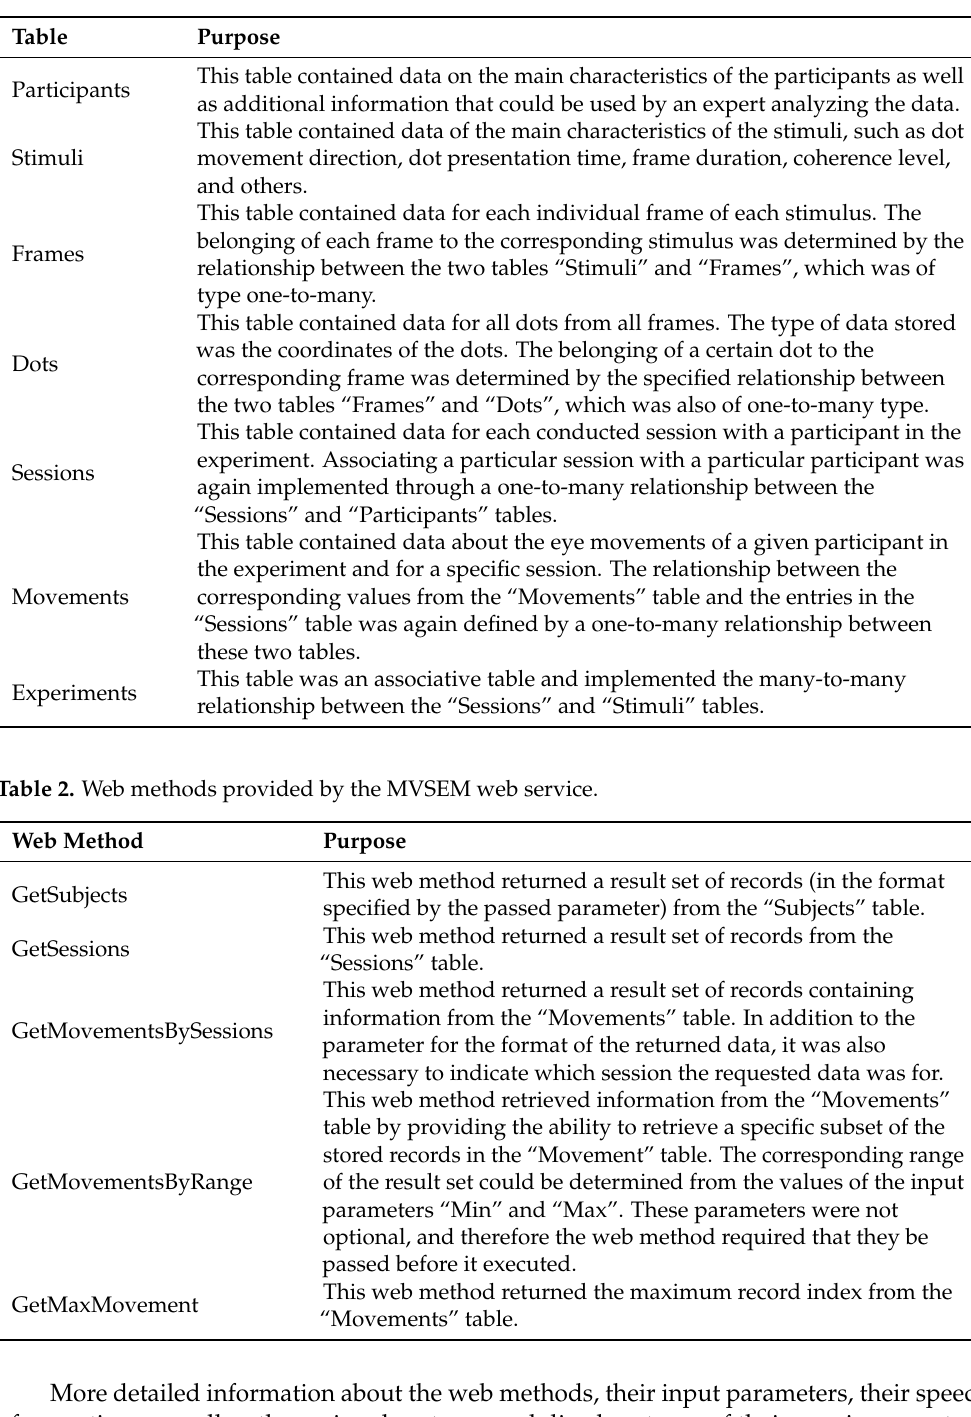
Table 1. Tables included in the MVSEMDB database.